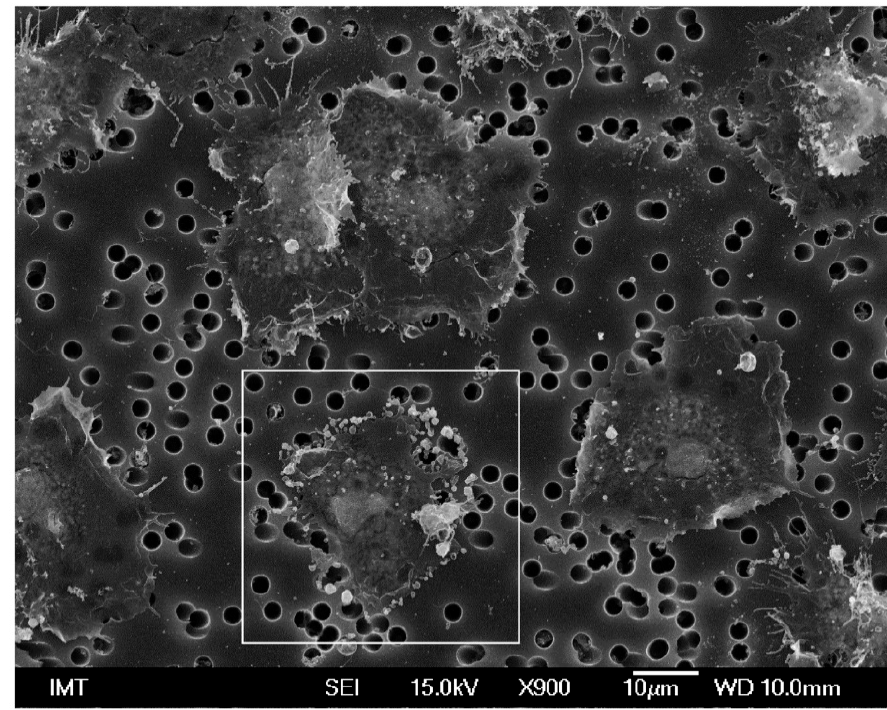
Figure 2. SEM images of hemocytes of M. galloprovincialis incubated for 30 min with PVP ‐ AuNPs (10 μ g/mL) in ASW suspension. In the framed cell, the presence of PVP ‐ AuNPs was investigated using Energy ‐ dispersive X ‐ ray (EDX) analysis, and the details are presented in Figure S2.